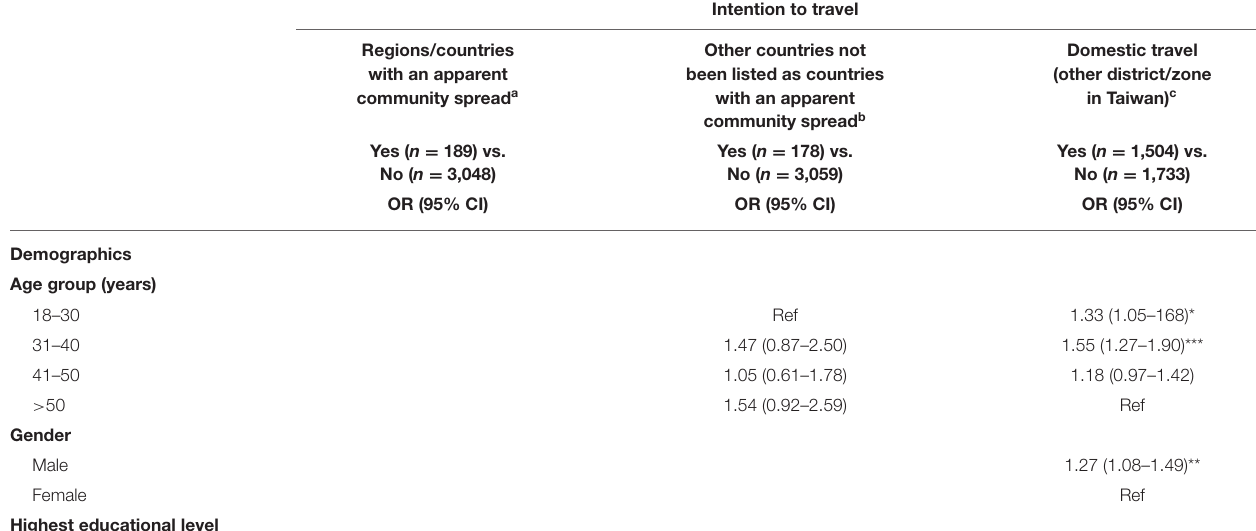
TABLE 2 | Multivariable regression analyses of factors associated with intention to travel in the next 1 month ( N =